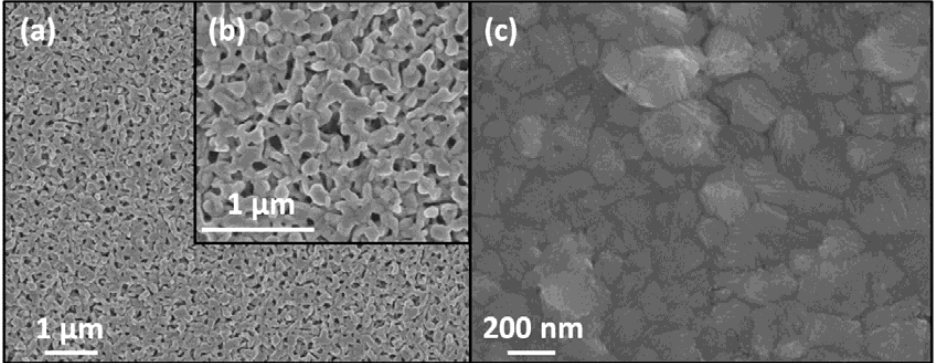
Figure 4. SEM micrographs of top surface of films: ( a ) the precursor film and ( b ) its enlarged fragment, and ( c ) the final perovskite film.